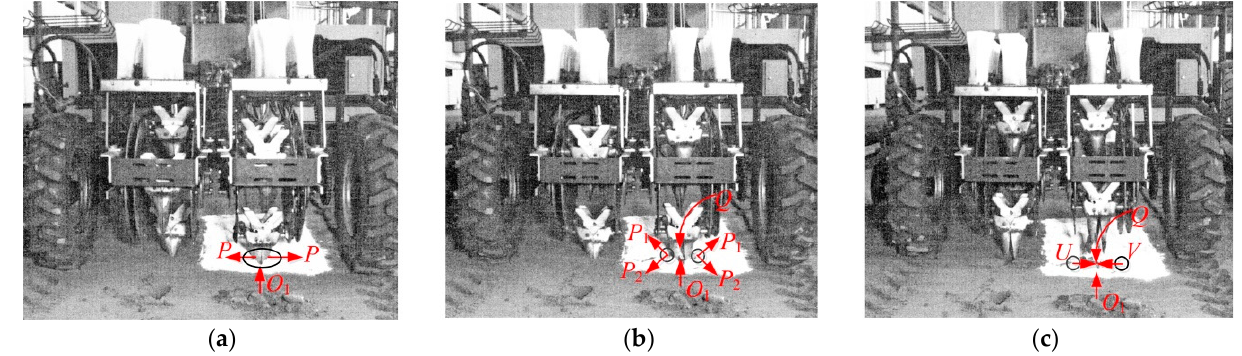
Figure 7. High ‐ speed photographic image analysis of soil disturbance at the contact interface. ( a ) The planter reaching the lowest point; ( b ) the duckbill opening to the maximum; and ( c ) the planter leaving the soil.